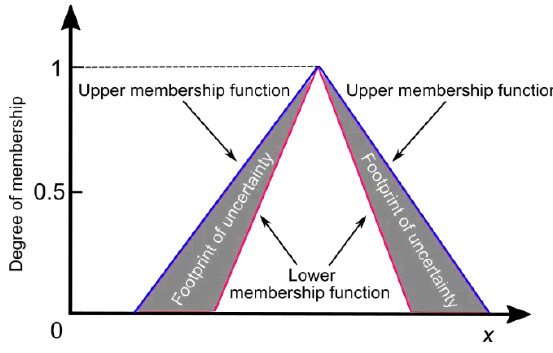
Figure 3. The footprint of uncertainty for an interval Type-2 fuzzy set.